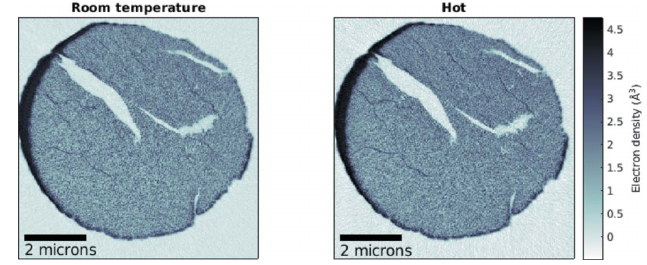
Figure 9 Axial tomographic slices of each measurement. Data displayed on the left were recorded at a set temperature of 50 (cid:2) C, and on the right at 600 (cid:2) C.